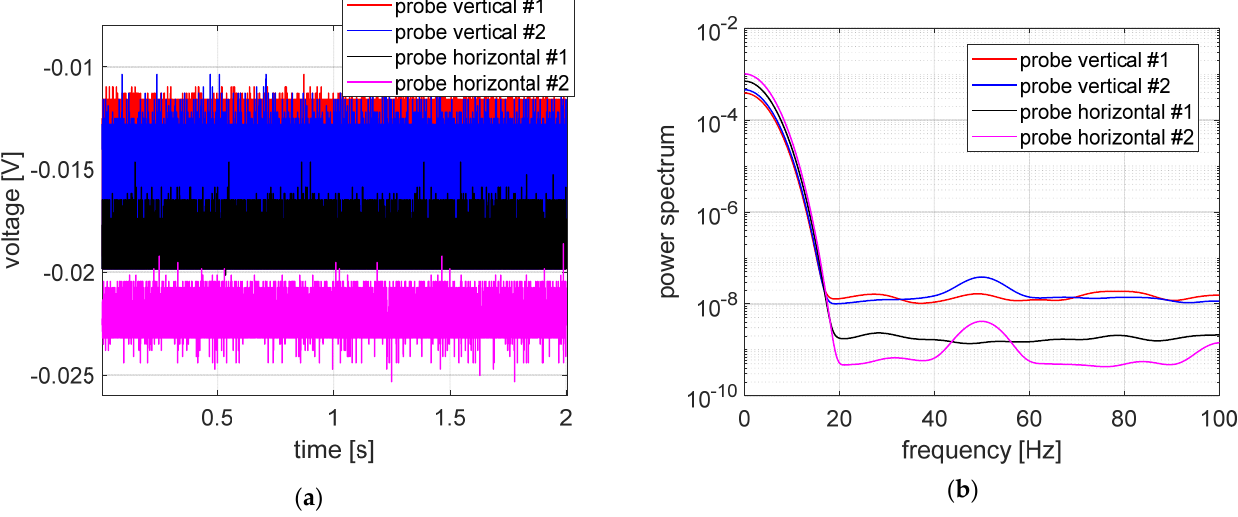
Figure 7. Measurement signals recorded with the power supply turned off for both the magnetic bearings and measuring sensors: ( a ) time courses, ( b ) signal power spectrum.